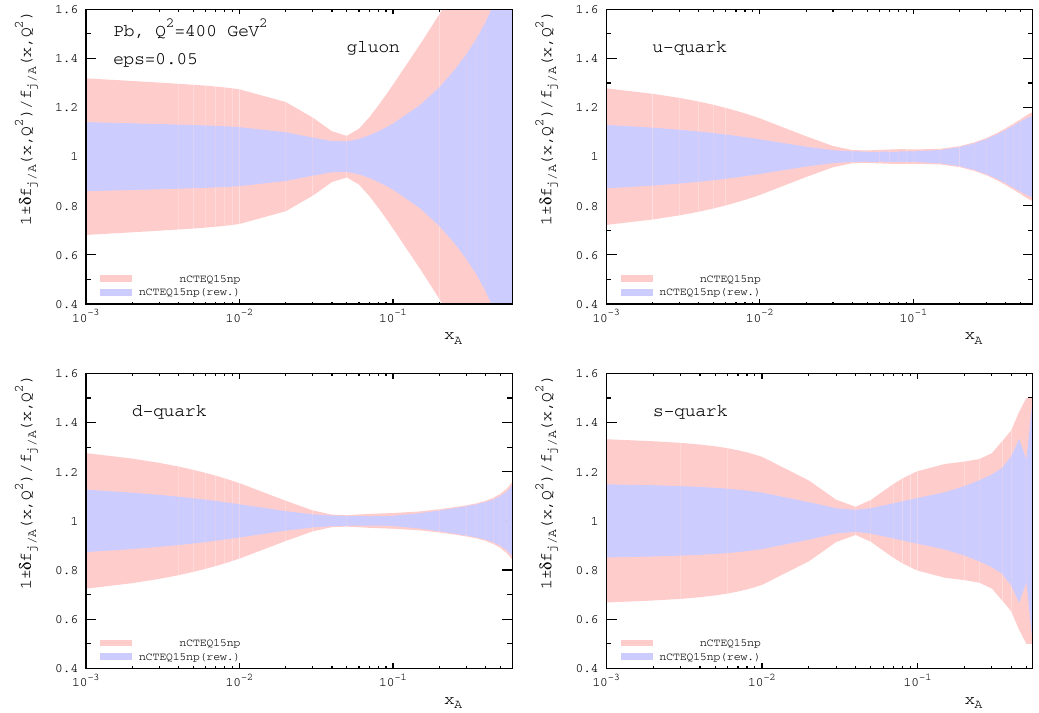
Fig. 6 The gluon, u -quark, d -quark, and s -quark nCTEQnp nPDFs as a function of x at Q 2 = 400 GeV 2 with (blue, inner band) and without (red, outer band) the Bayesian reweighting. The case of (cid:6) = 0 .